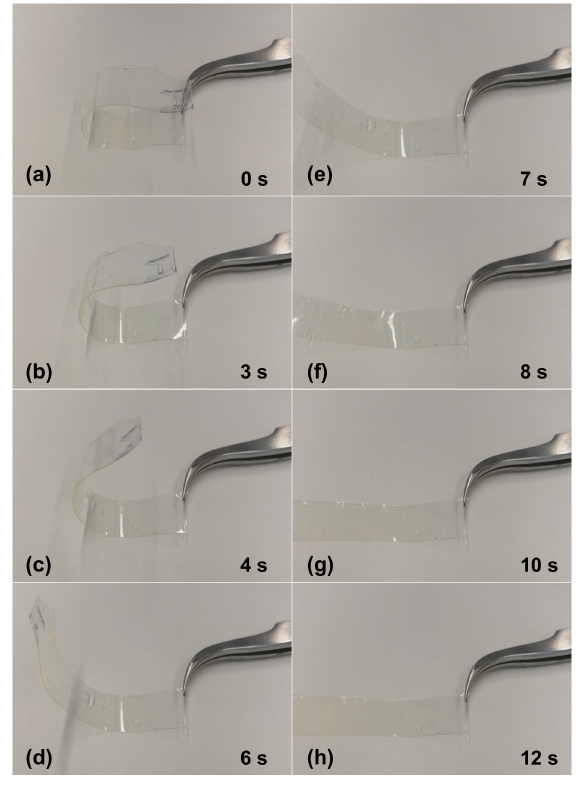
Figure 5. Shape-memory test of the crosslinked PETMP-TTT polymer free-standing film: ( a ) Digital photograph of free-standing PETMP-TTT film with fixed shape after cooling down below 0 ◦ C and ( b ), ( c ), ( d ), ( e ), ( f ), ( g ), and ( h ) shape recovery process at different time instances when heated with hot